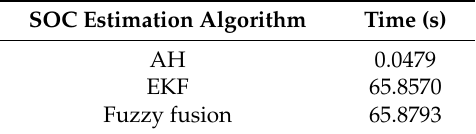
Table 6. Computing time (s) of various SOC estimation algorithms in the entire SOC